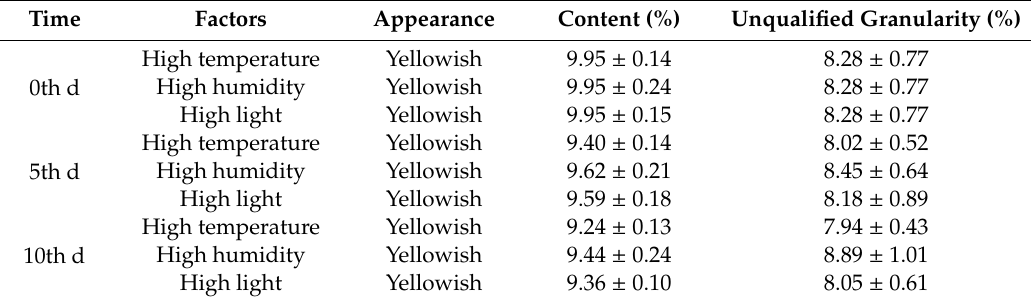
Table 3. The influence factor test of tilmicosin enteric granules (Mean ± SD, n = 3). Time